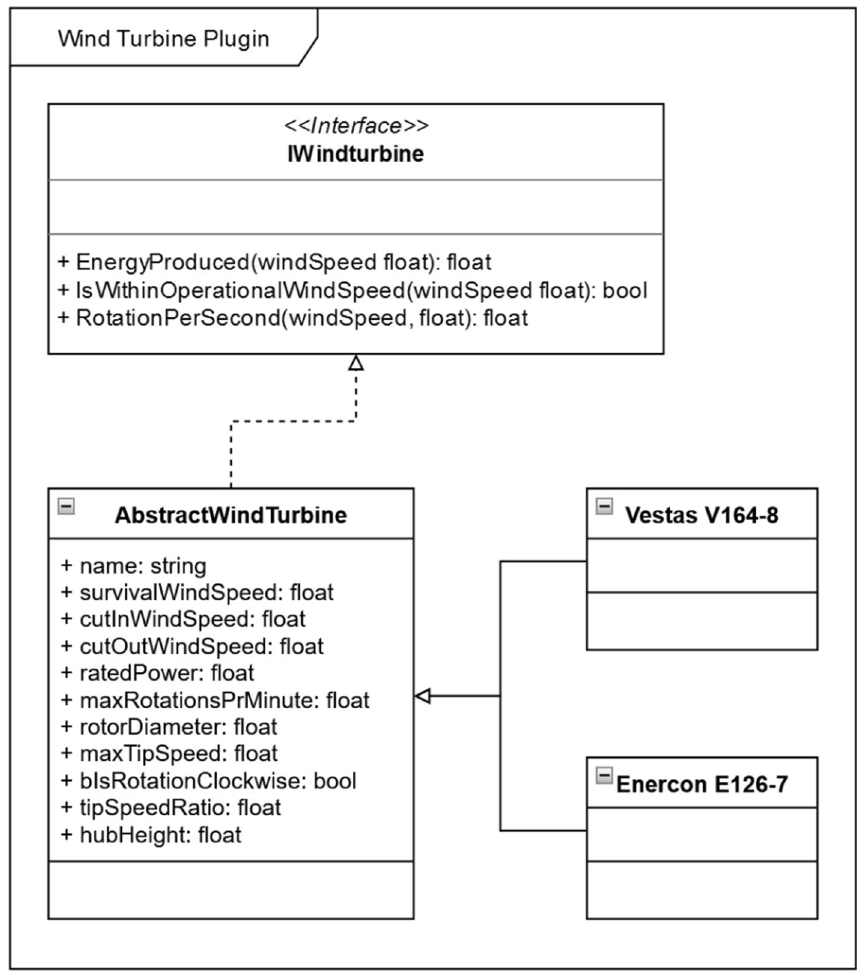
Fig. 11 The wind turbine class